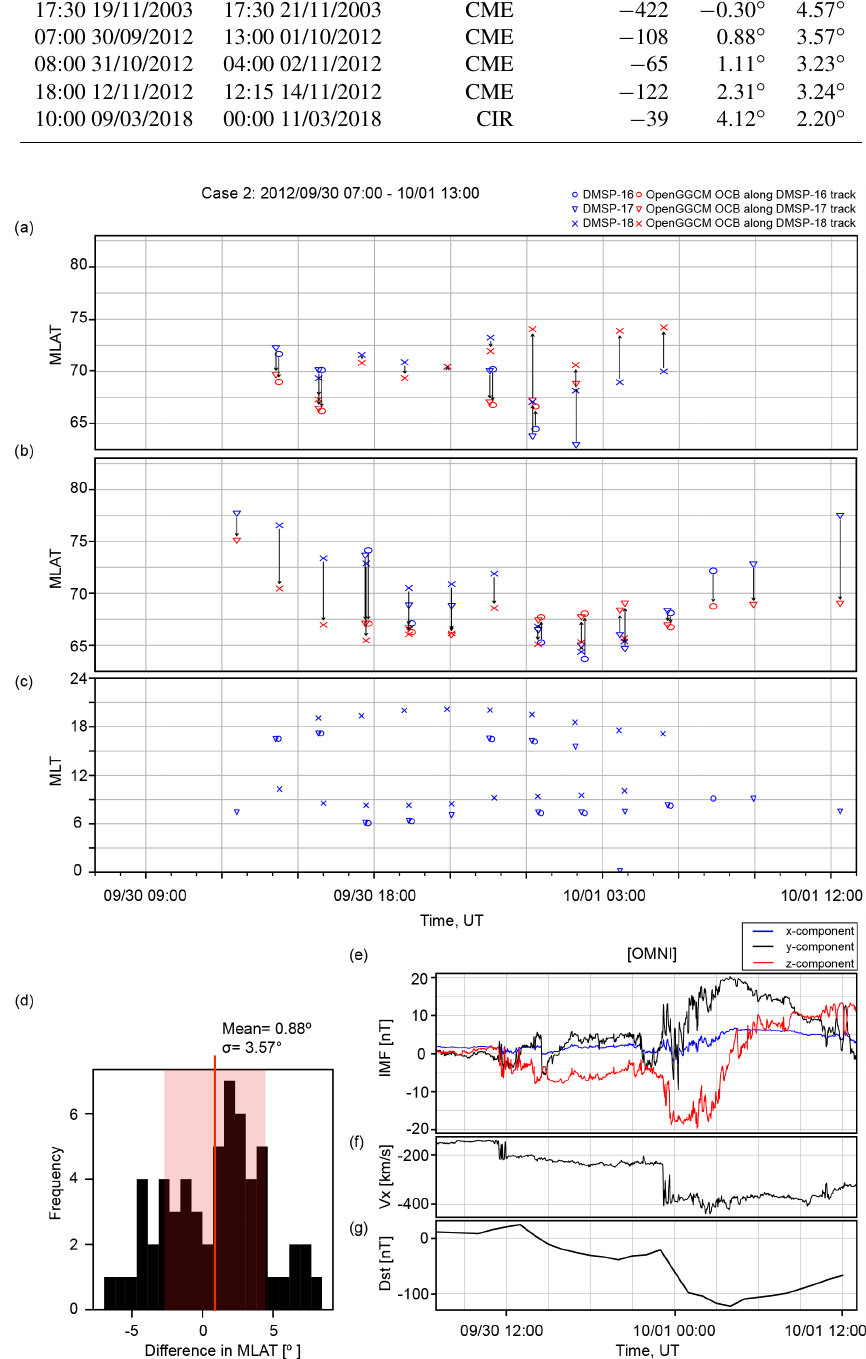
Figure 2. Comparison between the observed and simulated OCB latitudes for the 1 October 2012 event in the same format as Fig. 1.